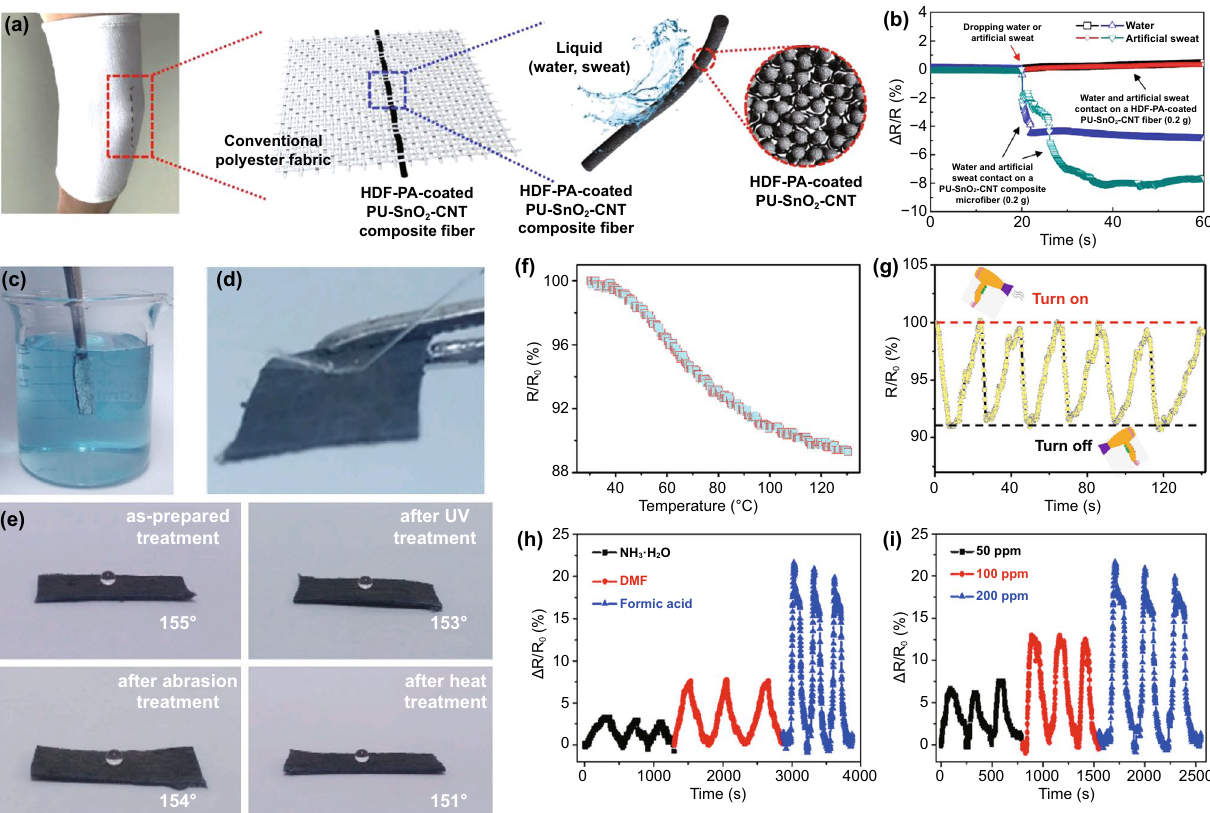
Fig. 12 a Photograph and schematic diagram of the prepared composite microfiber seamed in the elbow wrap, the fabricated fiber could repel both artificial sweat and water. b Relative resistance changes of the composite microfibers with and without the modification of HDF- PA depending on sweat and water [214]. Copyright © 2018 Wiley–VCH. c Photo of the mirror-like phenomenon of the sensor by immersion in water and d a column of water bouncing off. e Photo image showing the WCA variation after different treatments [138]. Copyright © 2019 Elsevier. f The relative resistance change depends on temperature from 30 to 130 ℃ . g The sensing behavior of the hot wind. h Cyclic sensing performance of different vapors under the concentration of 200 ppm. i Sensing performance of formic acid with different concentrations